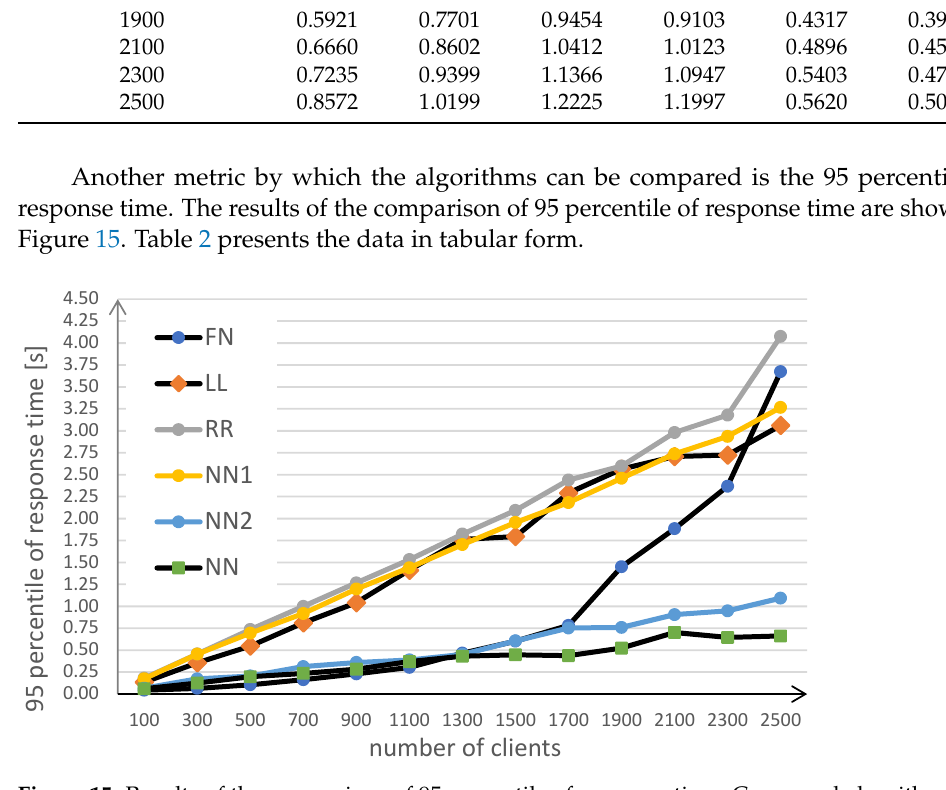
Figure 15. Results of the comparison of 95 percentile of response time. Compared algorithms: the proposed algorithm (NN) with the following research steps (NN1, NN2) and other popular methods of web server load balancing—FNRD, LL, RR. Table 2. Results of the comparison of 95 percentile of response time in tabular form.